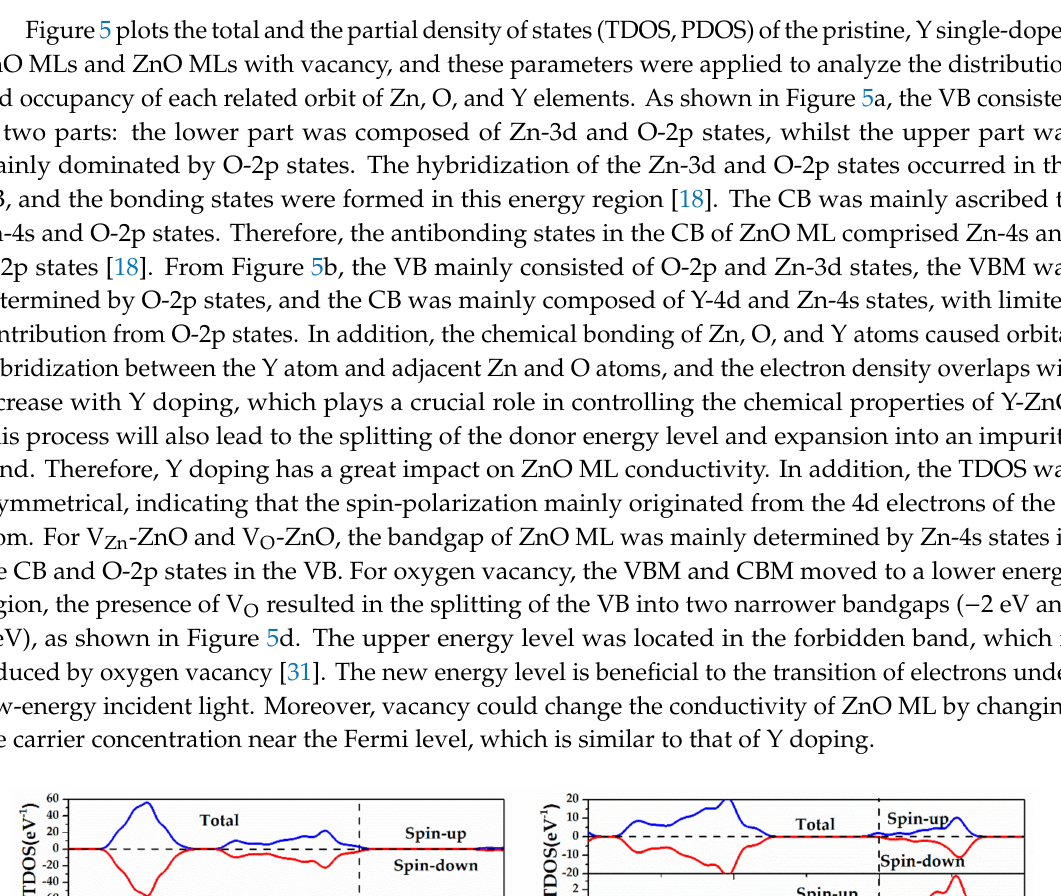
Figure 4. The band structures of ( a ) ZnO ML, ( b ) Y-ZnO, ( c ) V Zn -ZnO, and ( d ) V O -ZnO.